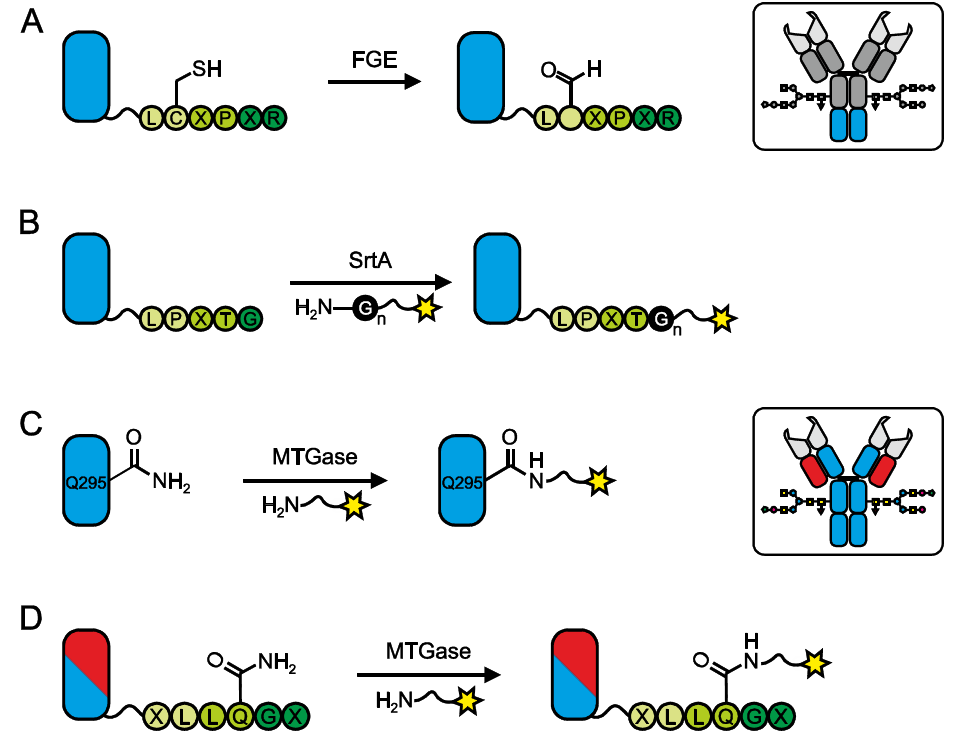
Figure 6. General concepts of antibody conjugation via tags. ( A ) The formylglycine generating enzyme (FGE) converts the cysteine of a LCXPXR tag into formylglycine, thereby creating a bioorthogonal aldehyde handle for site-specific chemical antibody conjugation. ( B ) Sortase A (Srt A) mediates that conjugation of an LPXTG motif with a polyglycine-functionalized ligand of interest (yellow star). General scheme of MTGase- mediated antibody modification targeting ( C ) the endogenous glutamine at position 295 or ( D ) a glutamine-containing